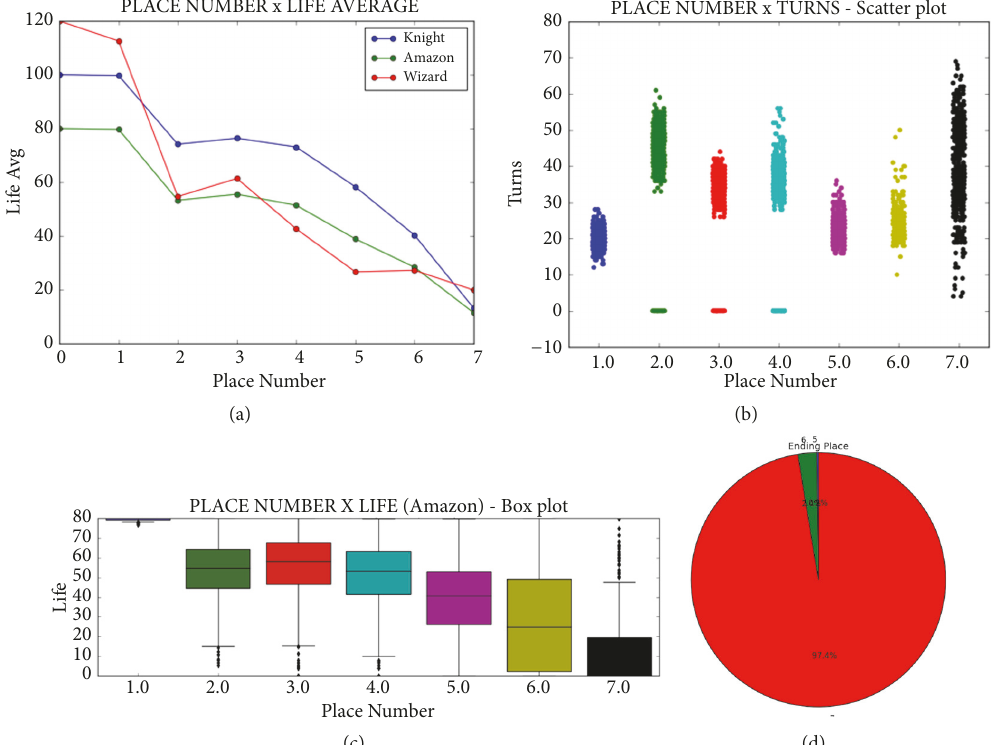
Figure 9: Simulation results from the second iteration: (a) average life at each place, (b) number of turns at each place, (c) life of the Amazon Hero at each place, and (d) place where simulation